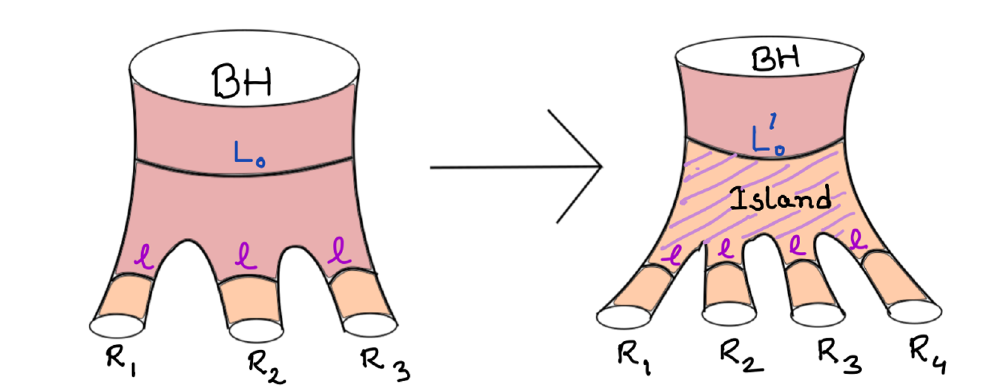
Figure 6. Change of preferred HRT in n -boundary model.